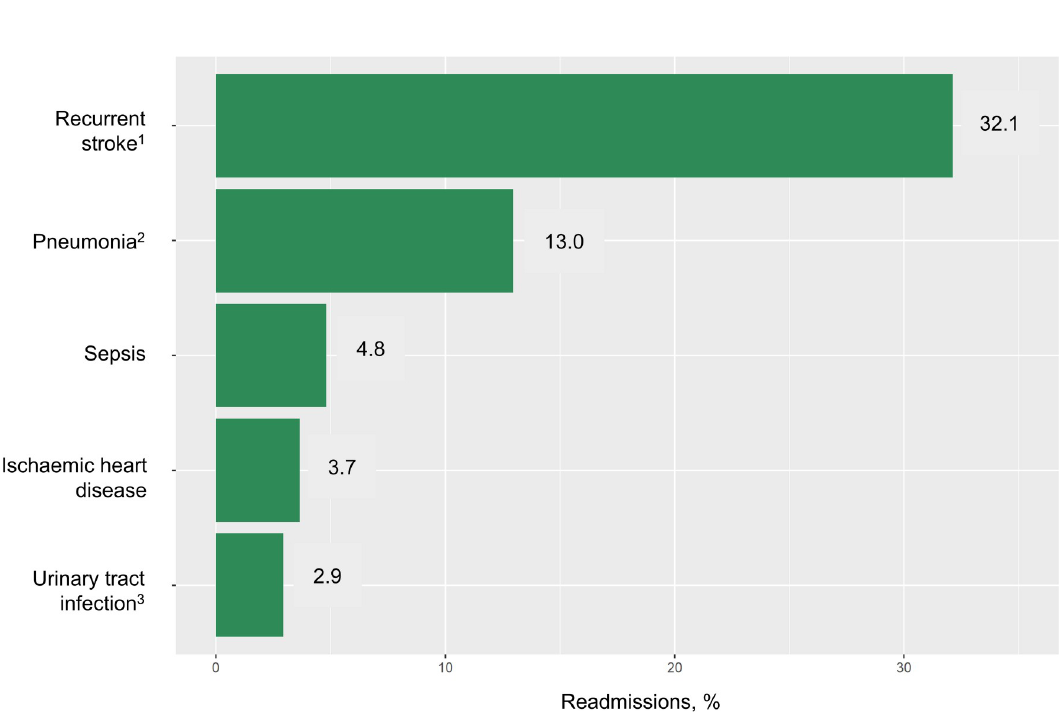
Fig 3. Top causes of 28-day readmissions in 2015 (n = 2877). 1 Recurrent stroke includes I60–I64 and G45. 2 Pneumonia also includes J69. 3 Urinary tract infections consisted of N39 (91.5%) and N30–N32 (8.5%).